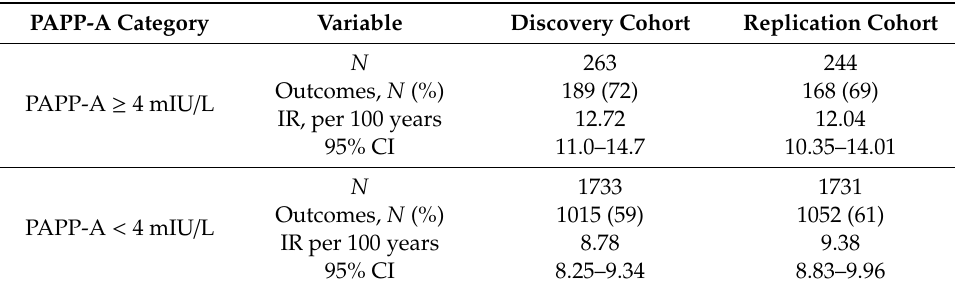
Table 2. Incidence rates of the composite outcome by PAPP-A